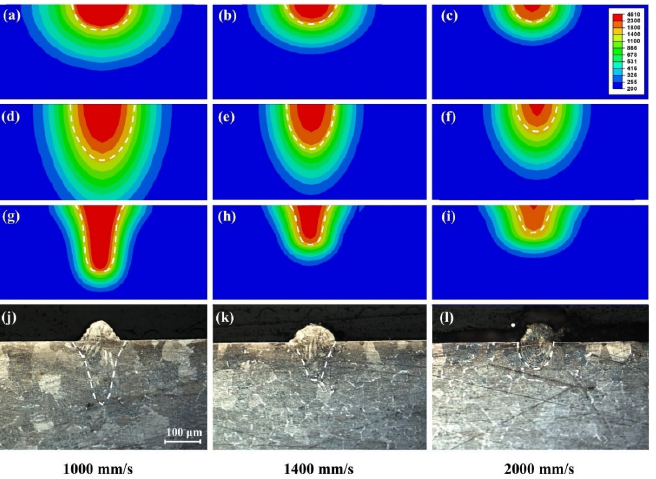
Figure 6. Melt pool geometries with a laser power of 400 W: ( a – c ) Gaussian surface heat source; ( d – f ) double ellipsoid volumetric heat source; ( g – i ) surface–volumetric coupled heat source; ( j – l ) ex- perimental.